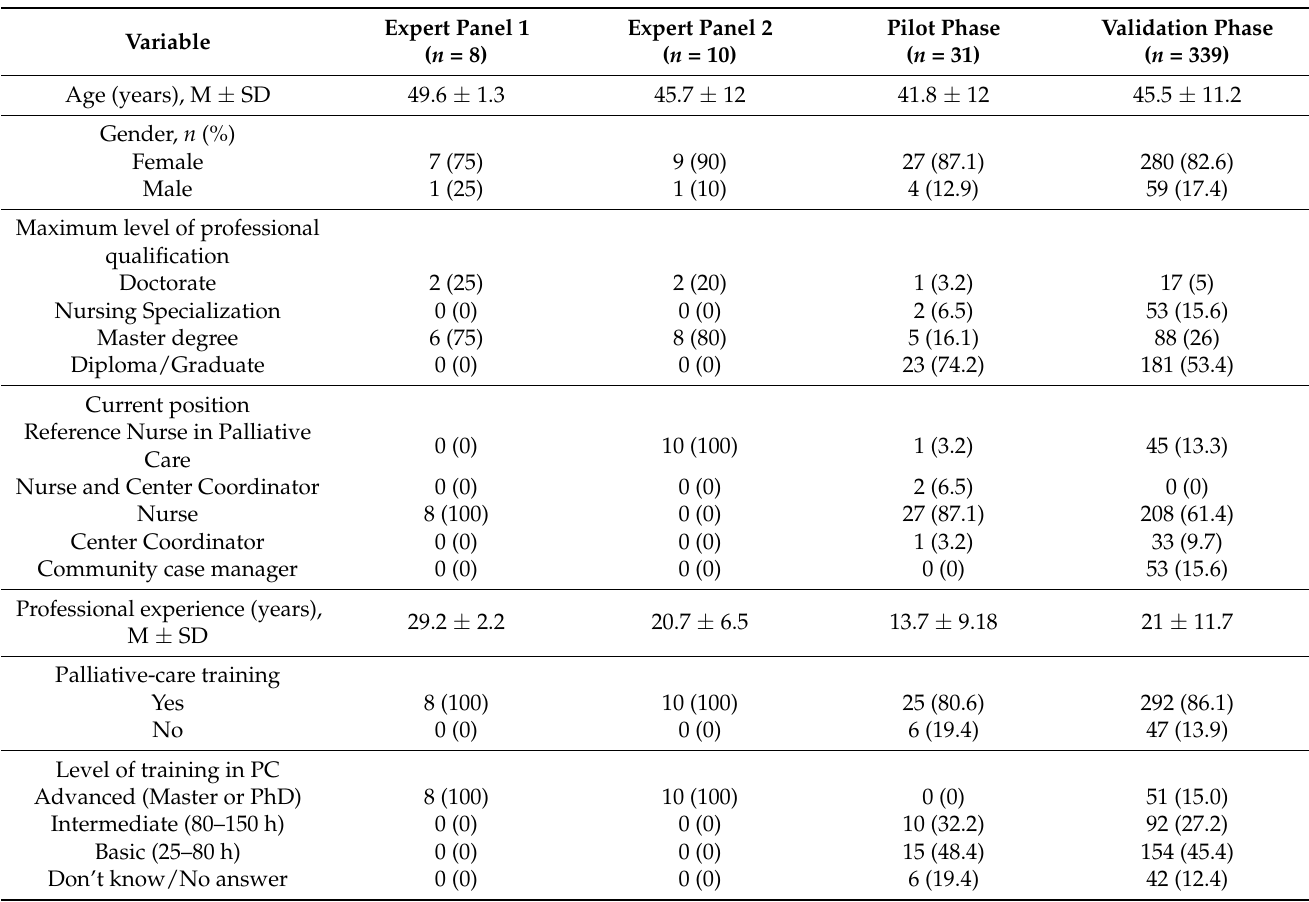
Table 2. Sample socio-demographic